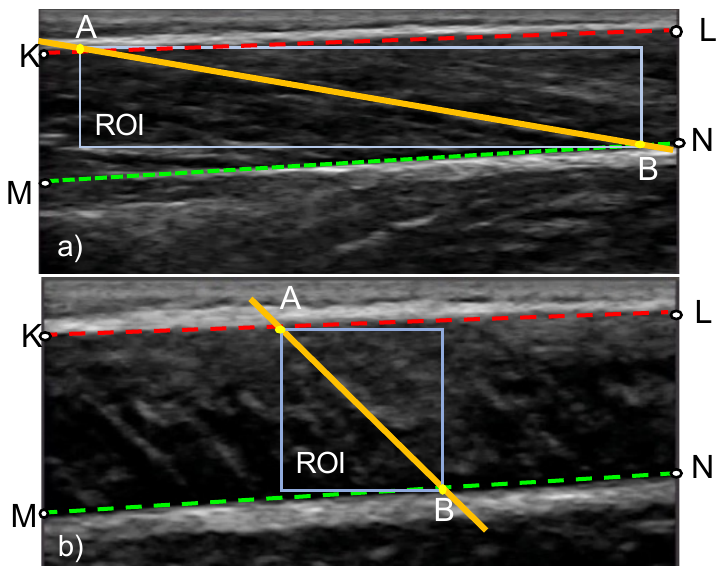
Figure 5. Definition of the region of interest (ROI) in an ultrasound image of a muscle at rest ( a ) and during maximal contraction ( b ). The geometric points that are used in the calculation of FL and PA are also shown. Lines KL and MN, respectively, correspond to the top and bottom boundary of the fascicle band. Points A and B denote the insertion points of the fascicle direction line.